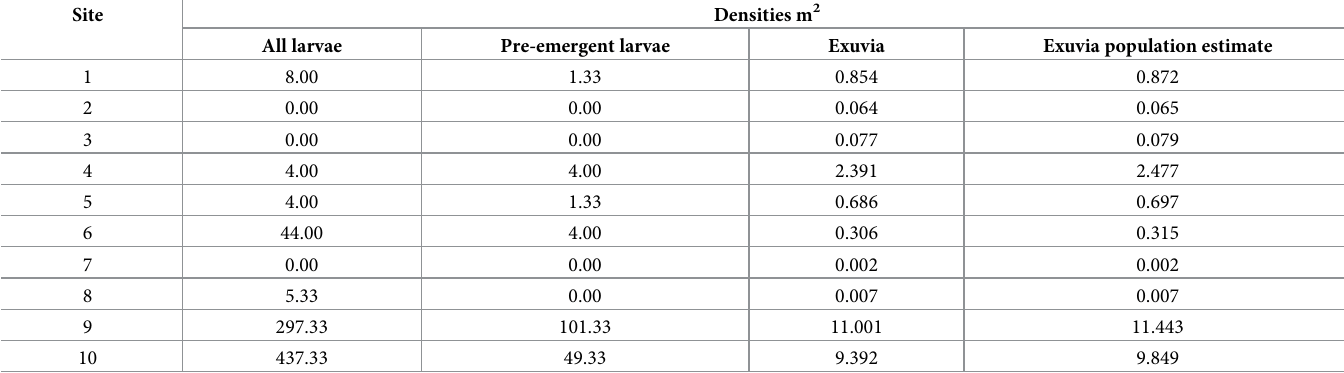
Table 3. Densities in m 2 of Pteronarcys californica pre-emergent larvae, all larvae, total exuvia counted, and three pass exuvia population estimates from the Hug- gins Closed Capture model collected from April-June 2010 from the Colorado, Fraser, and Gunnison Rivers.